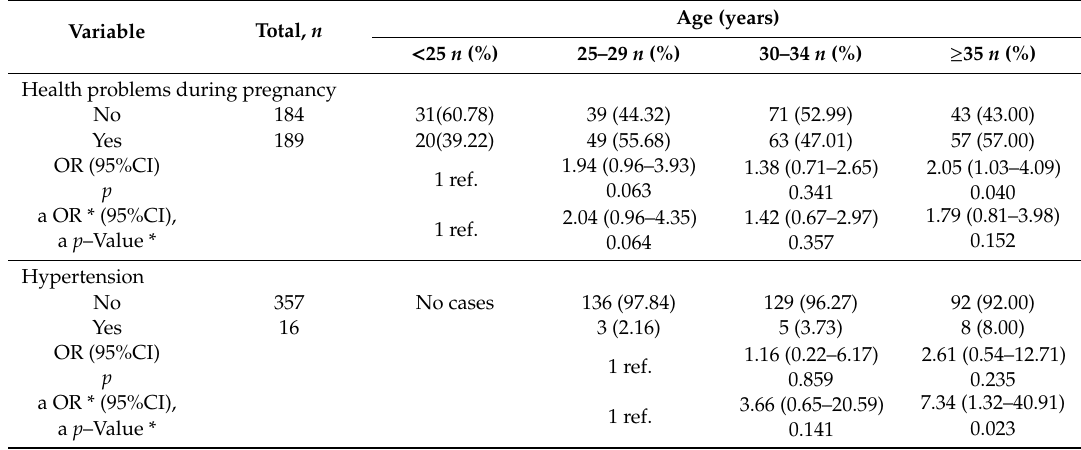
Table 3. Analysis of pregnancy, birth and puerperium variables stratified for